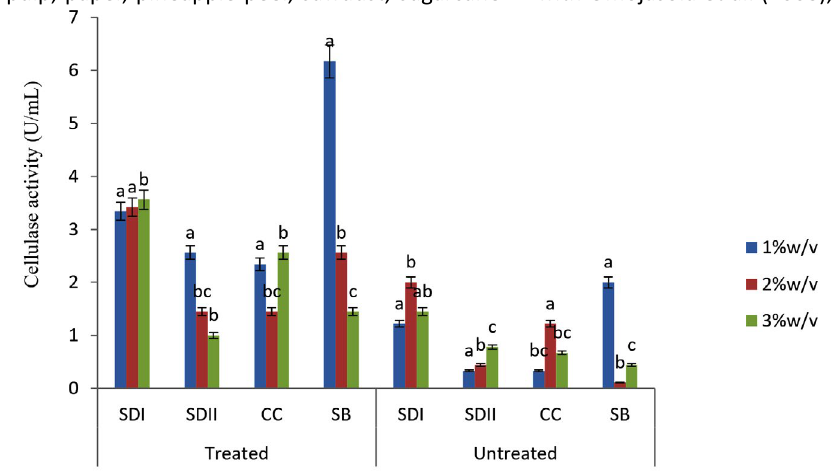
Fig. 2. Degradation ability of the isolates SAC1 on Lignocellulose Substrates